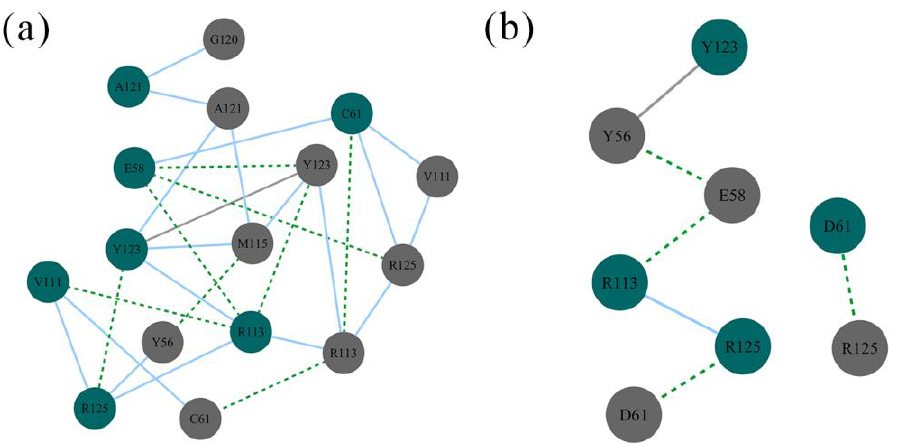
Figure 11. PPI networks of the ( a ) dimer and ( b ) S systems. Residues on A PD-L1 and B PD-L1 are represented as green and grey nodes, respectively. Hydrogen bonding, van der Waals, and π-π stacking interactions are depicted by green dashed, blue solid, and grey solid lines, respectively.